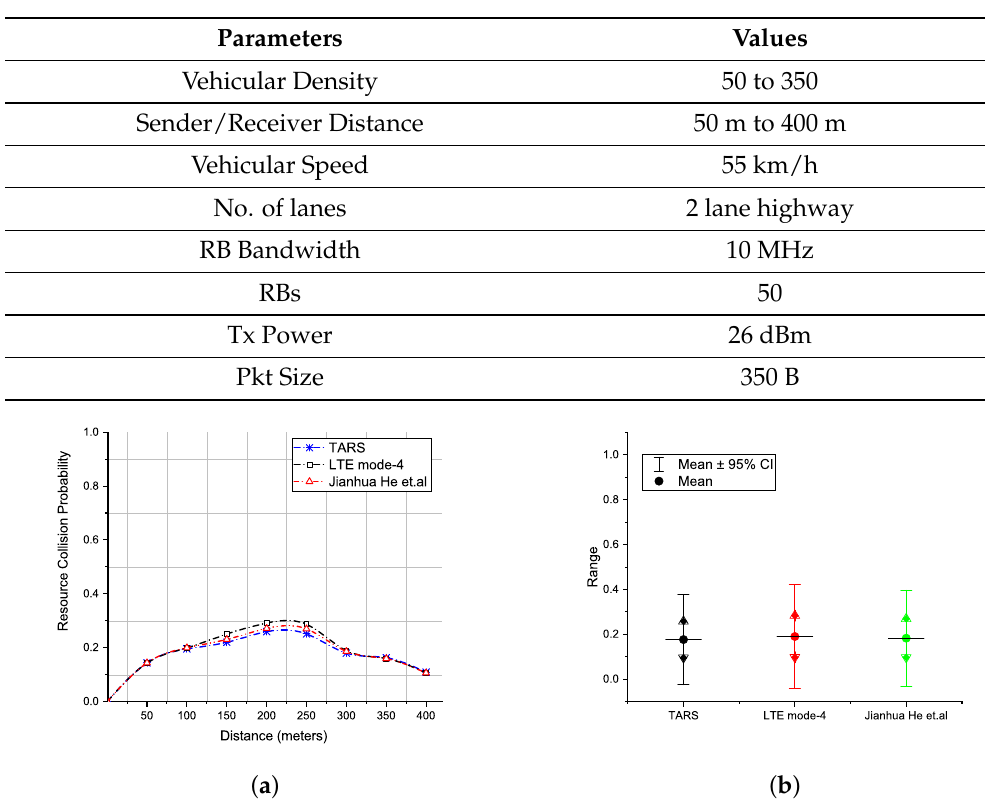
Figure 12. Resource collision probability; ( a ) of the Markov model and, ( b ) a confidence interval of